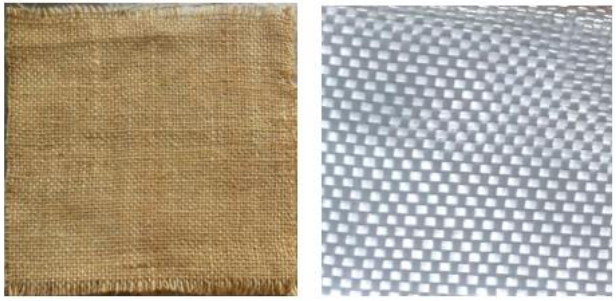
Figure 1: Left) Jute fabric, Right) Glass fabric